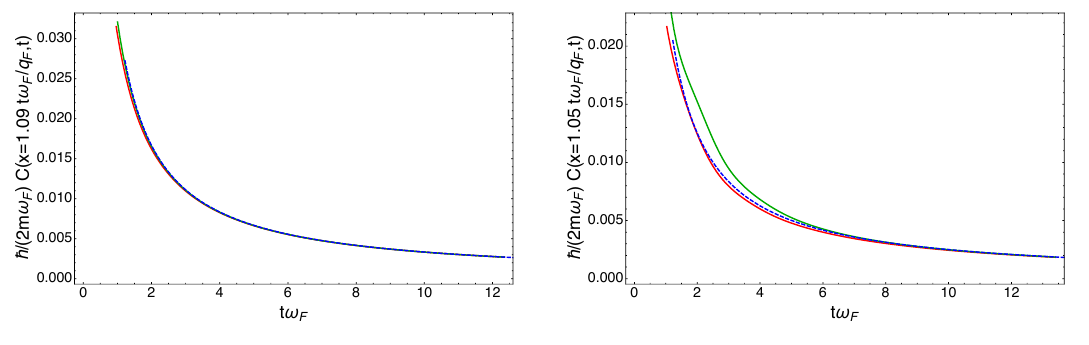
Figure 9: Correlation function C ( x , t ) ≡ 〈 σ ( x , t ) σ ( 0,0 ) 〉 in a thermal state for x = 2 α t as a function of t at c = 4, for β = 1 and D = 0.38 (left) and β = 3 and D = 0.386 (right). The three curves depict the real part (red), the modulus (green) and the GHD approximation (dashed